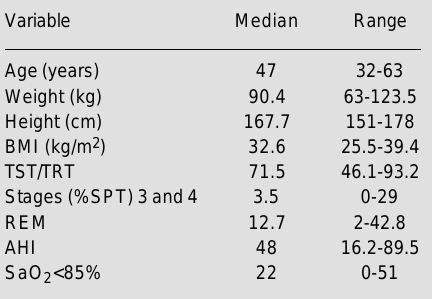
Table 1 - Physical characteristics and polysomno- graphic data of OSA patients. BMI: Body mass index; TST: total sleep time; TRT: total recording time; SPT: sleep period time, de- fined as the result of TST subtracted from the initial and final latencies; AHI: